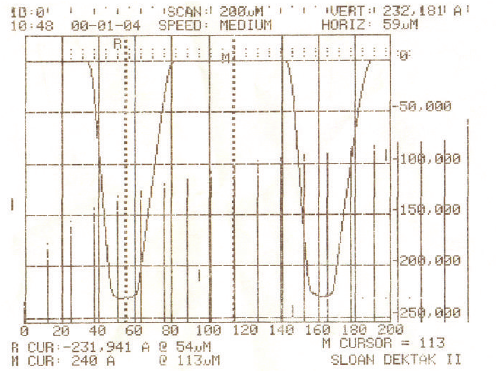
Figure 11: Results of the quartz mold surface with the stylus profiler.